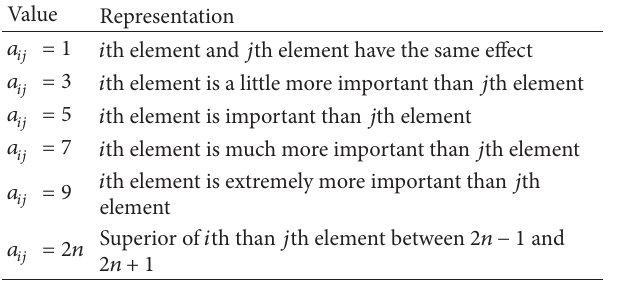
Table 1: Configurations in the correlation matrix. Value